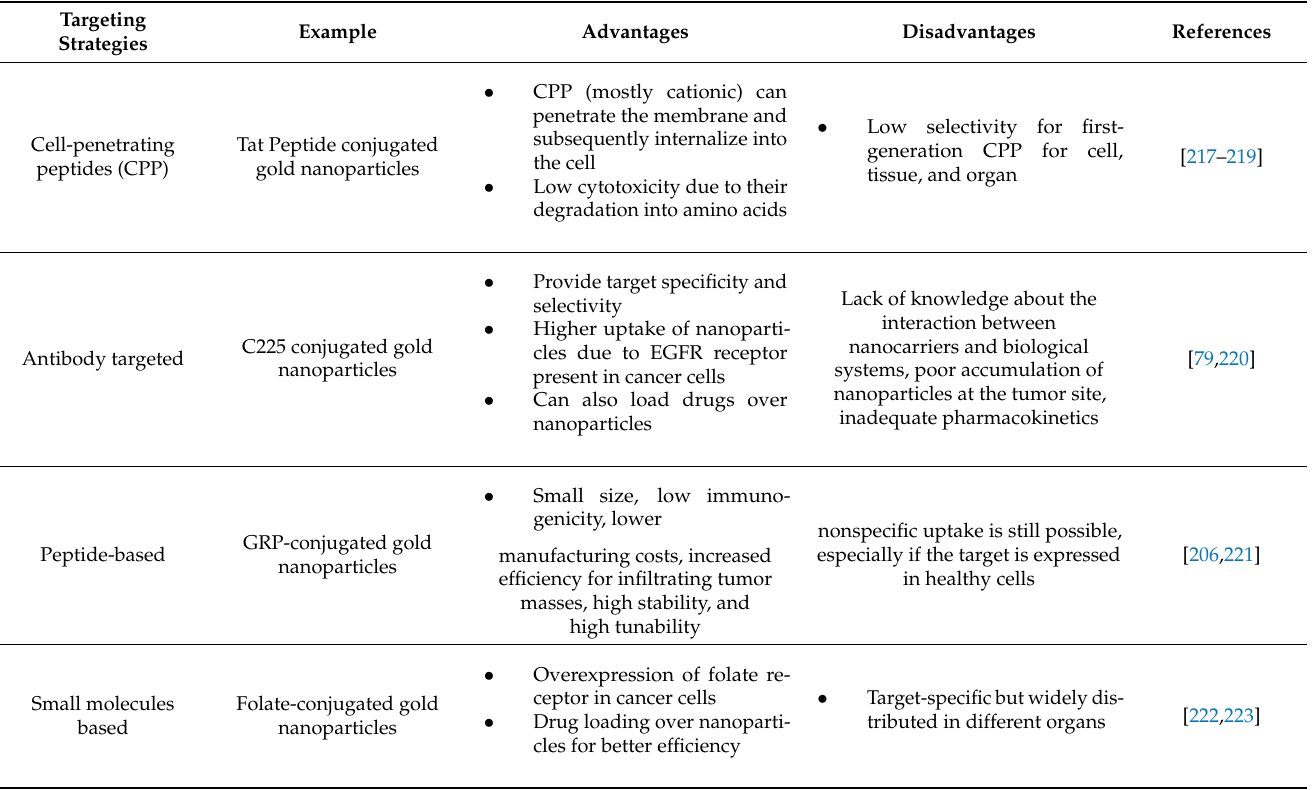
Table 3. Described various targeting moieties conjugated to gold nanoparticles for cancer therapy and